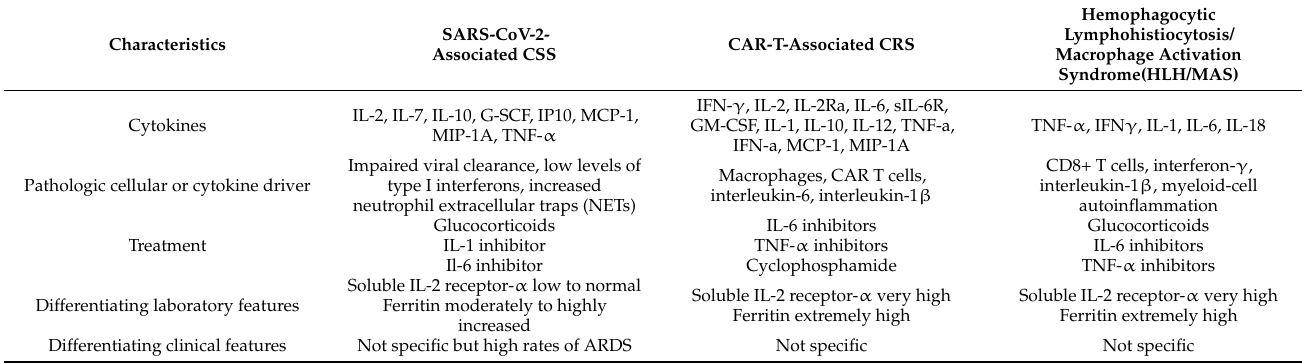
Table 4. Characteristics of SARS-CoV-2 cytokine storm syndrome (CSS), CAR-T cell therapy-associated cytokine